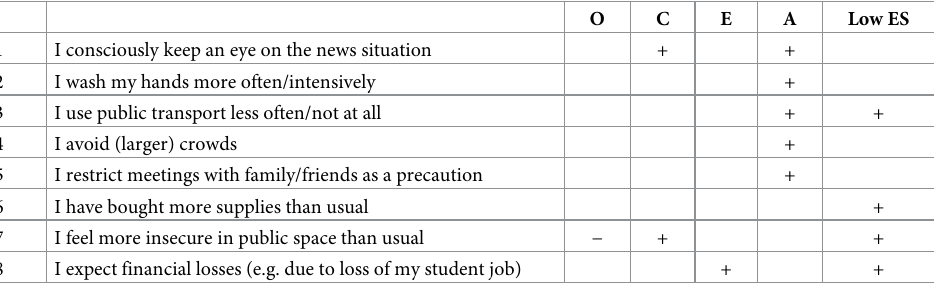
Table 3. Associations found between the Big Five personality traits and students’ thoughts, feelings, and behav- iors during the first three weeks of the COVID-19 pandemic in Germany. O C E A Low